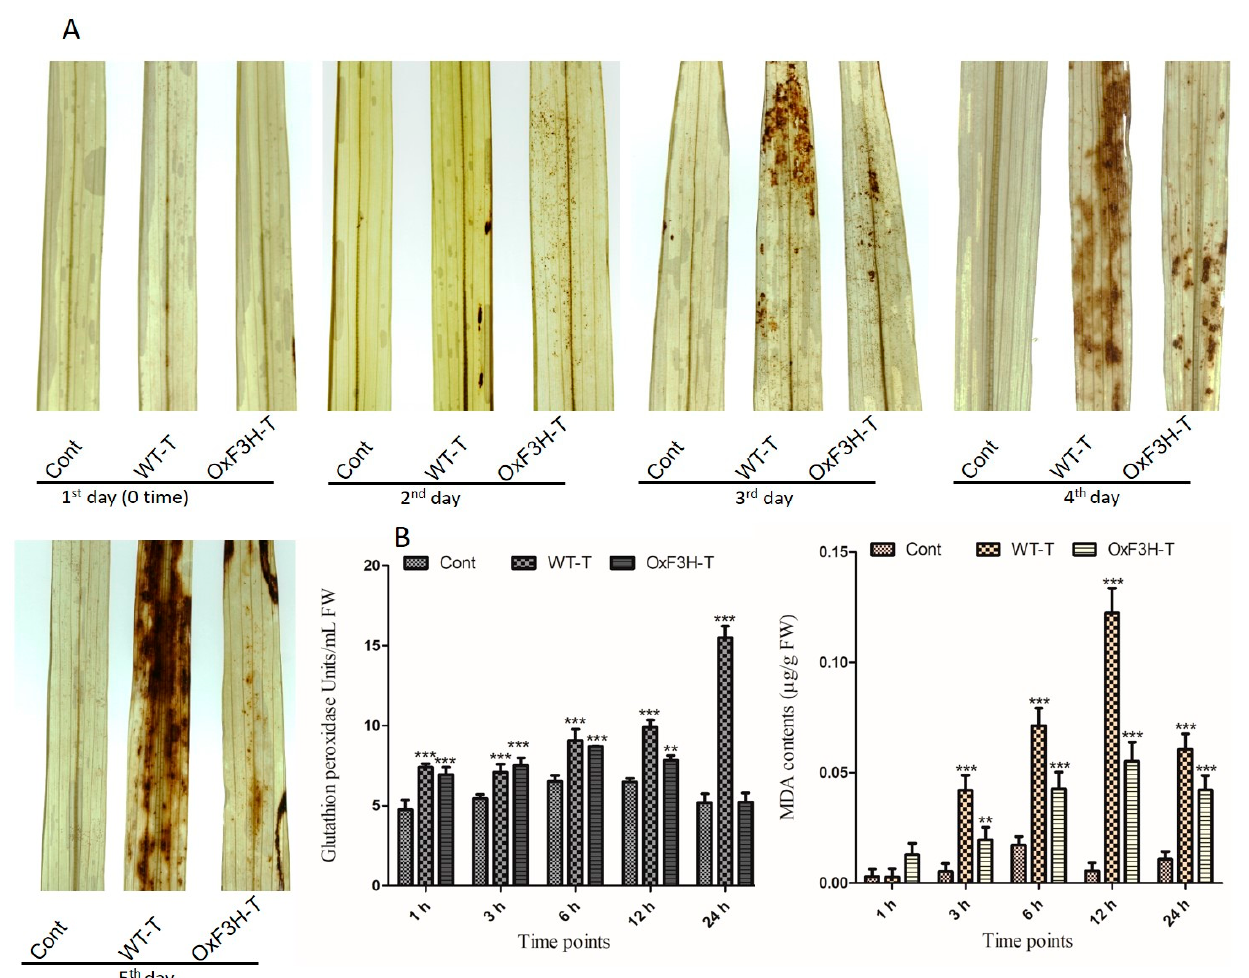
Figure 3. H 2 O 2 detection with DAB staining and antioxidant accumulation in leaf segments of the control, OxF3H, and WT plants in response to BLB stress. ( A ) Histochemical detection of H 2 O 2 after each DPI until 5 days. ( B ) Quantitative accumulation of antioxidants; the right graph shows MDA contents and the left graph shows glutathione peroxidase (GPX) activity. Bars indicate mean ± standard deviation and ** shows p ≤ 0.01) and *** shows p ≤ 0.001 significant difference, as analyzed using two-way ANOVA and a Bonferroni posttest.